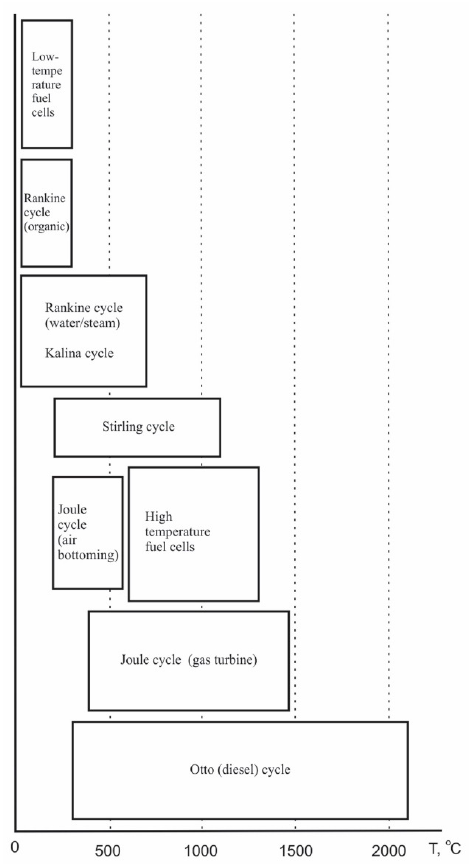
Figure 1. Classification of power generation systems based on working temperature, redrawn from [47].